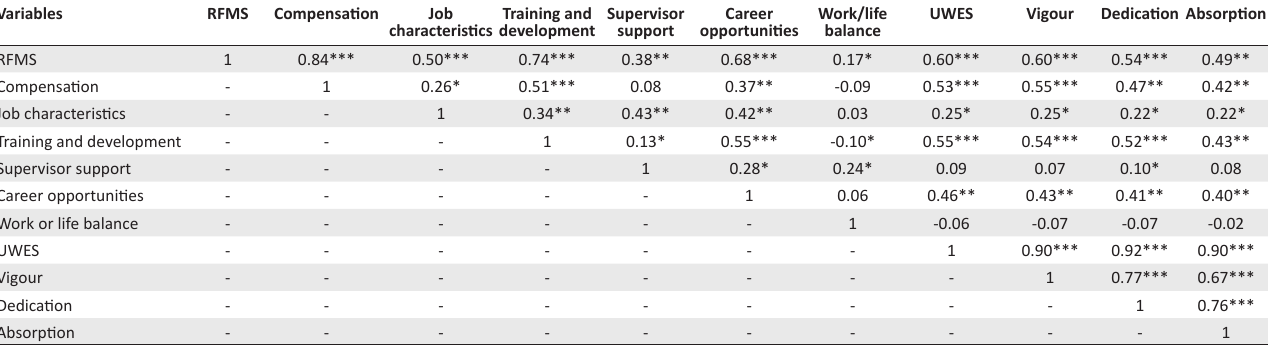
TABLE 3: Correlations between the Retention Factors Measurement Scale and Utrecht Work Engagement Scale ( N = 278). Variables RFMS